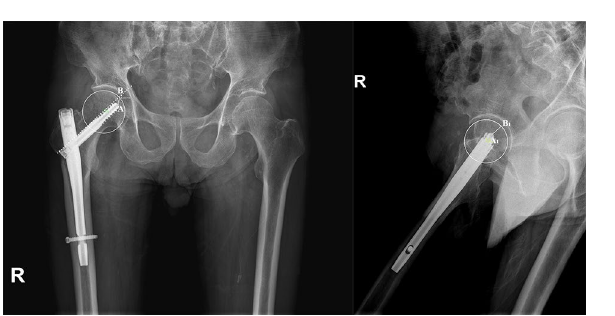
Figure 4. Assessment of the TAD in the anterior–posterior plane and the lateral plane. The Tip Apex Distance (TAD) is represented by the sum of AB and A 1 B 1